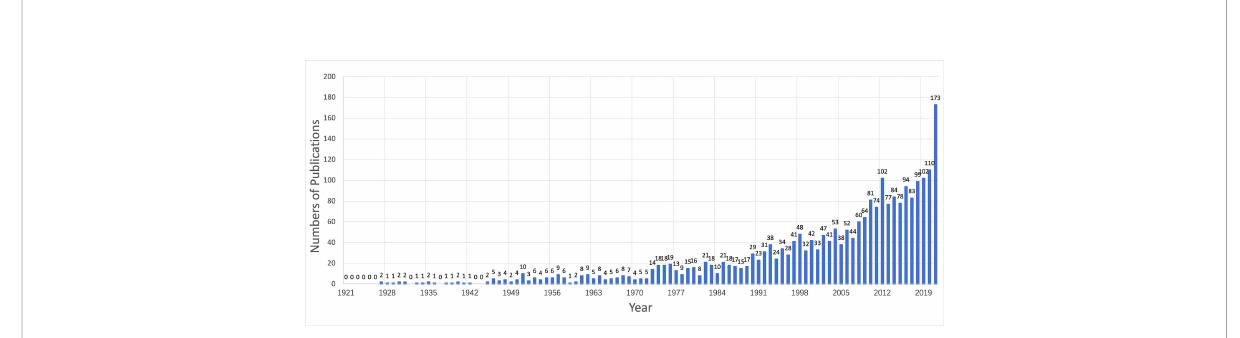
FIGURE 1 The annual quantities of adult-onset Still ’ s disease articles from 1921 to